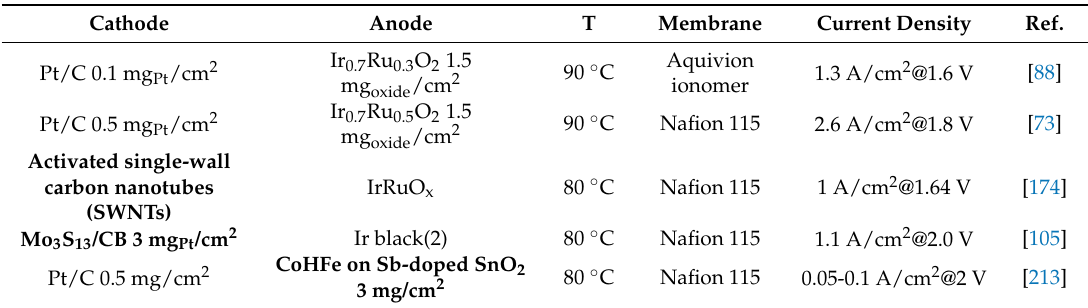
Table 5. Comparison between full PEM WE cells based on purely noble metal catalysts and those with EACs in the cathode or